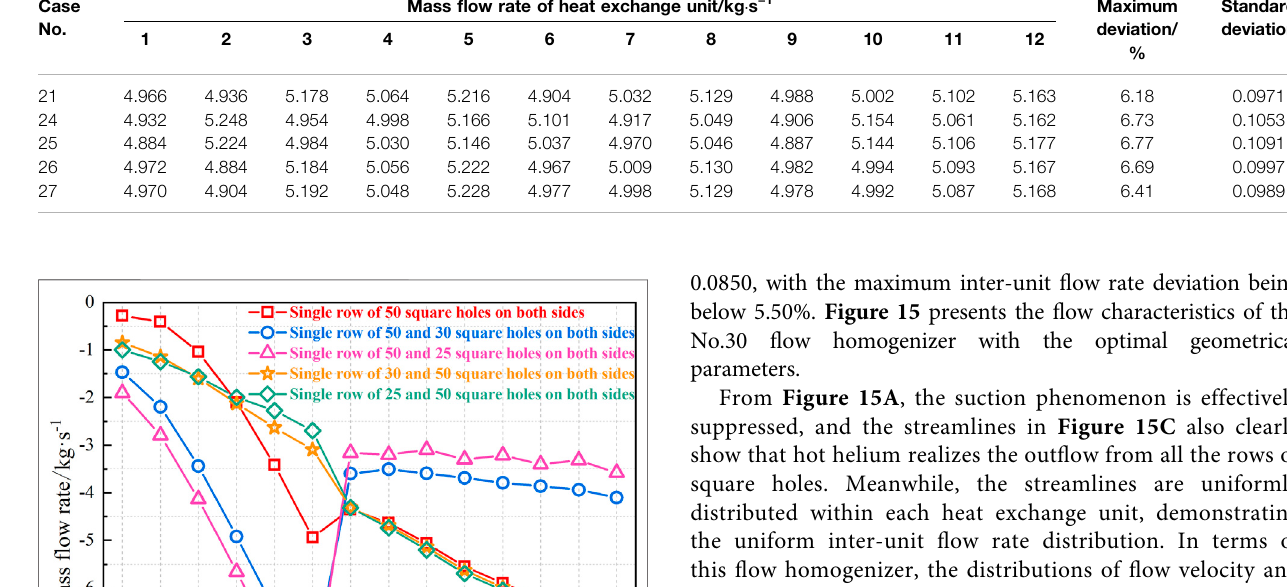
TABLE 10 | Numerical results of inter-unit fl ow rate distribution for fl ow homogenizers with different square hole numbers in a single row. Case No.